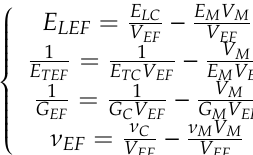
Table 1. Properties of the equivalent fibre for SWCNT (10,10) [10].